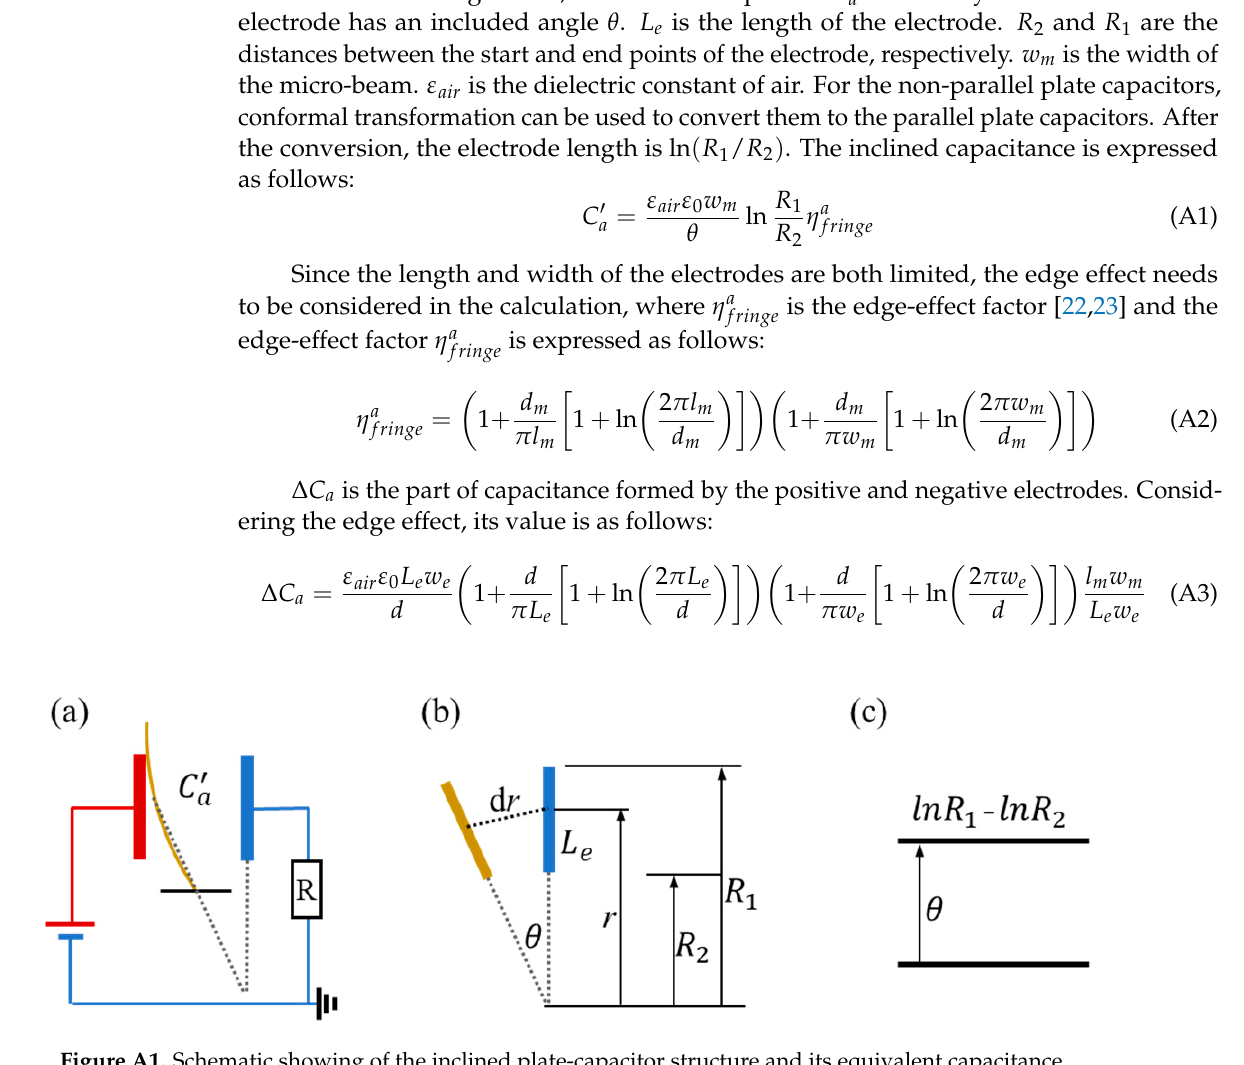
Figure A1. Schematic showing of the inclined plate-capacitor structure and its equivalent capacitance. In this paper, the simulating parameters utilized for electrostatic force calculation are shown in Table A1. Table A1. Parameter values of the simulation